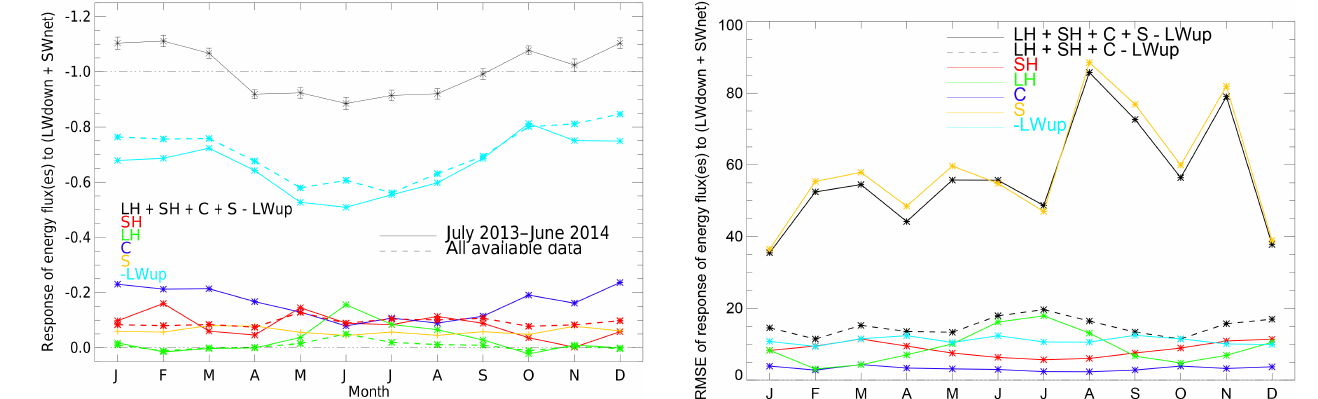
Figure 10. Root mean square error (Wm − 2 ) computed from the differences between the measured response of a given term (or com- bination of terms) and the estimated monthly responses in Fig.